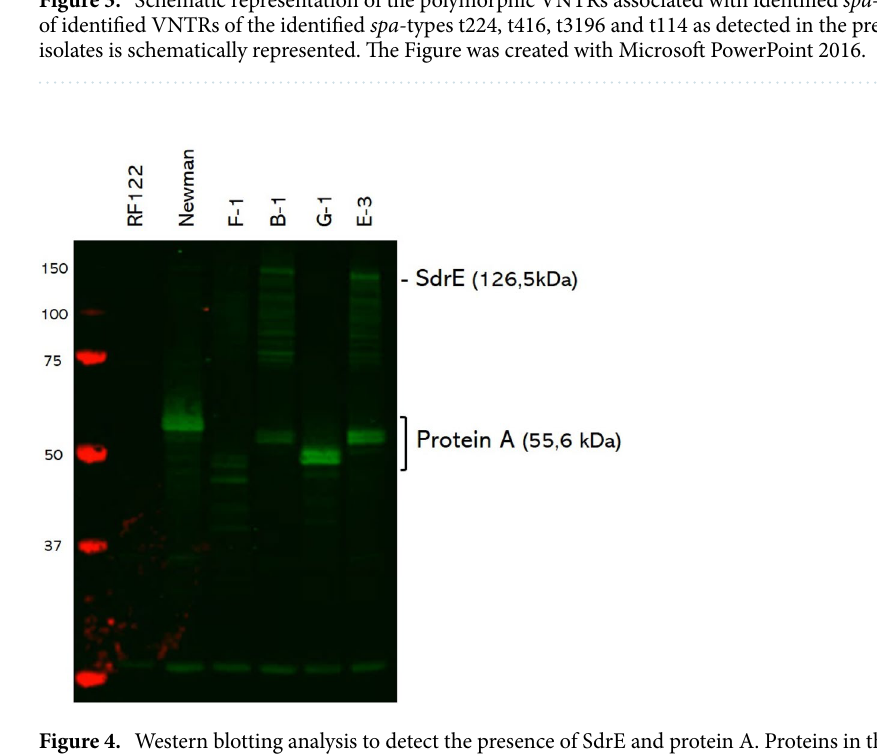
Figure 4. Western blotting analysis to detect the presence of SdrE and protein A. Proteins in the cellular fractions of S. aureus strains RF122 and Newman, and the mastitis isolates F-1, B-1, G-1 and E-3 were separated by LDS-PAGE and transferred to a nitrocellulose membrane. To visualize the presence of SdrE and protein A, the membrane was incubated with SdrE-specific rabbit antibodies (1:5000) and, subsequently, with an IRDye800CW-labelled goat anti-rabbit IgG secondary antibody (1:10,000). Note that protein A is detected by its capacity to bind rabbit IgG. The sizes of the marker proteins are indicated in kDa at the left side of the membrane. On the right side, the position of SdrE- and protein A-specific protein bands is marked. The complete original Western blot is presented as Supplemental Fig. S2. The Figure was created with Microsoft PowerPoint 2016.